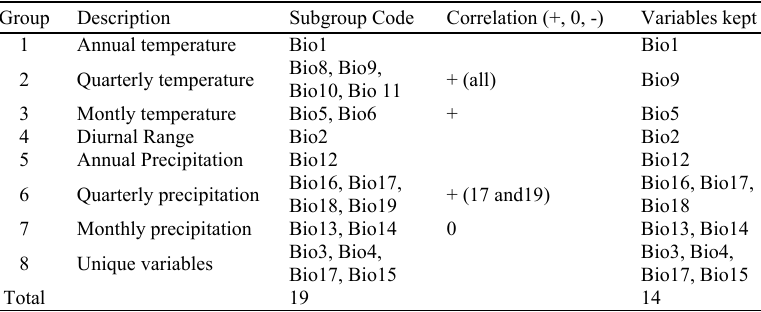
Fig. 3: Topographic and soil variables used in the study [aspect (a), slope (b), soil (c)] Table 1: Summary of correlation analysis results using ENM tools